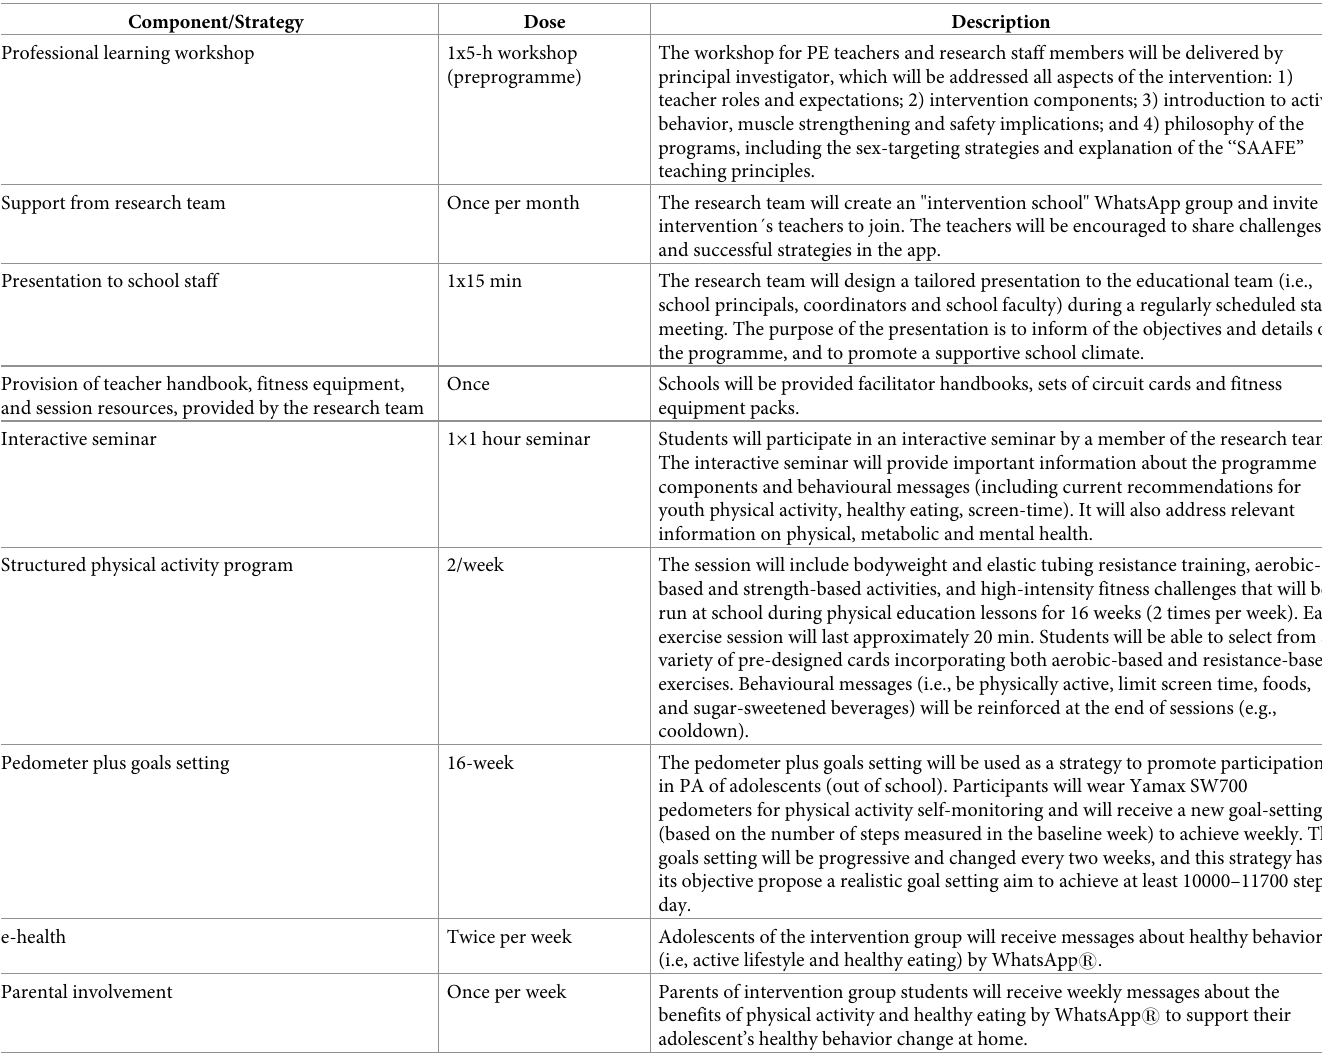
Table 1. Intervention and implementation